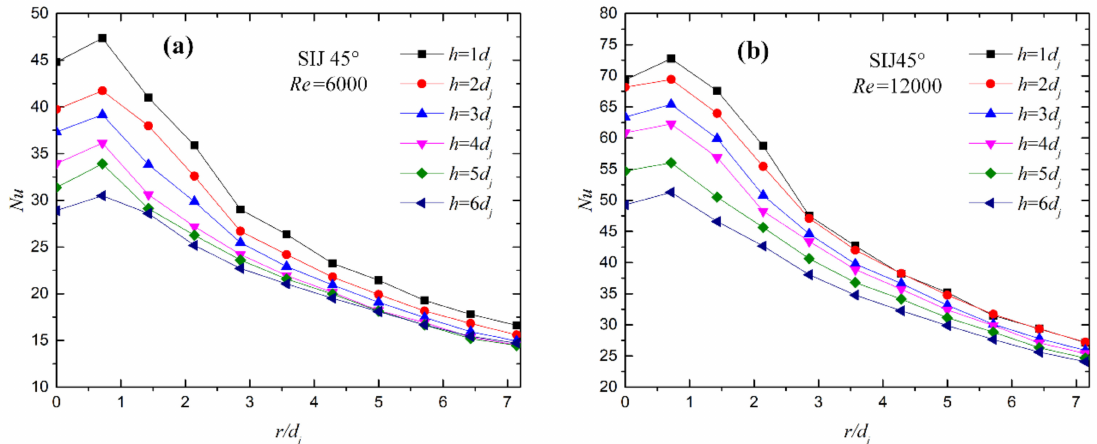
Figure 15. Experimental results of Nu with different jet spacings: ( a ) Re = 6000 and ( b ) Re =